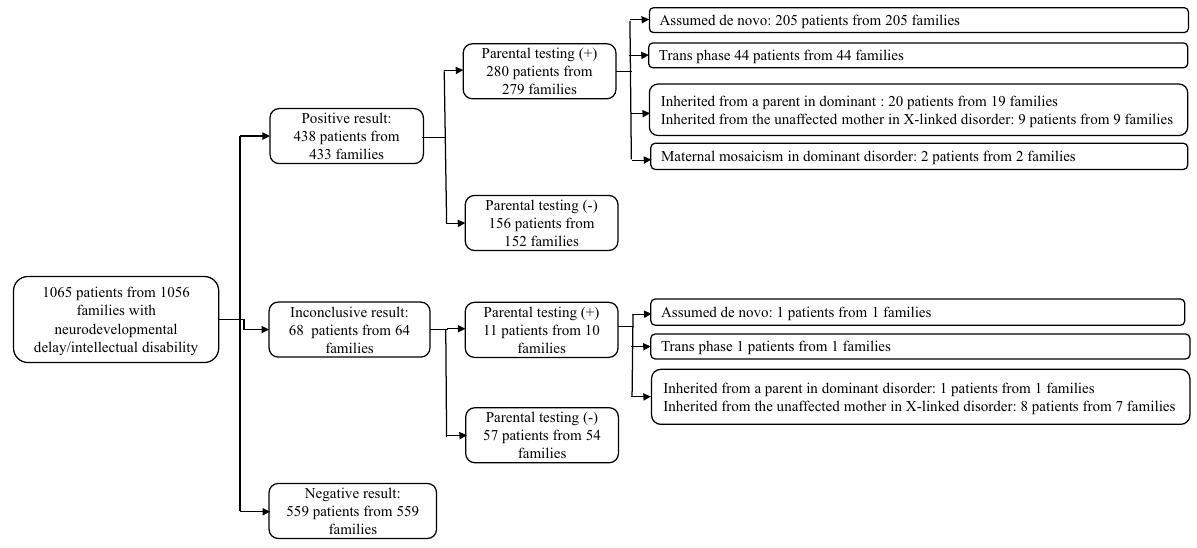
Fig. 3 Schematic diagram showing patients divided according to the three reported